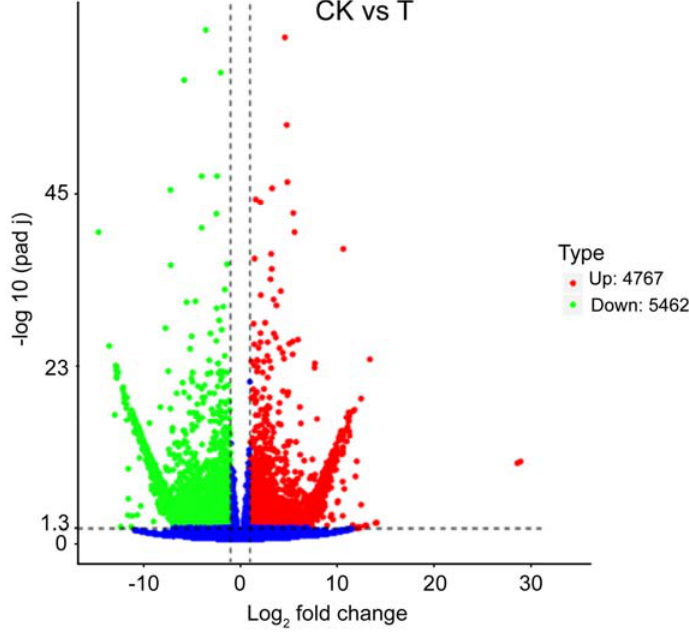
Figure 3. Volcano map of DEGs in the treatment groups. Table 3. Top 30 genes showing significant differential expression under drought stress.